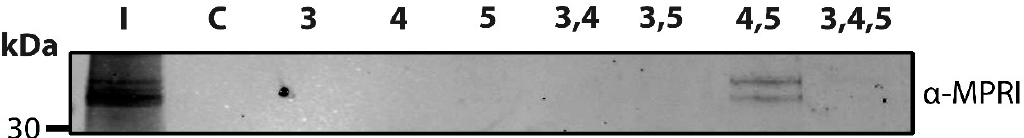
Figure 2. MPRIP specifically interacts with Phosphatidylinositol 4,5-bisphosphate (PIP2). Various PIP-coated agarose beads were used as a bait to pull-down interacting proteins from HeLa nuclear fraction. The membrane was WB analyzed with anti-MPRIP antibody. I—input 2%; C—control beads; 3—PI(3)P, 4—PI(4)P; 5—PI(5)P; 3,4—PI(3,4)P2; 3,5—PI(3,5)P2; 4,5—PI(4,5)P2; 3,4,5—PI(3,4,5)P3. n = 3.